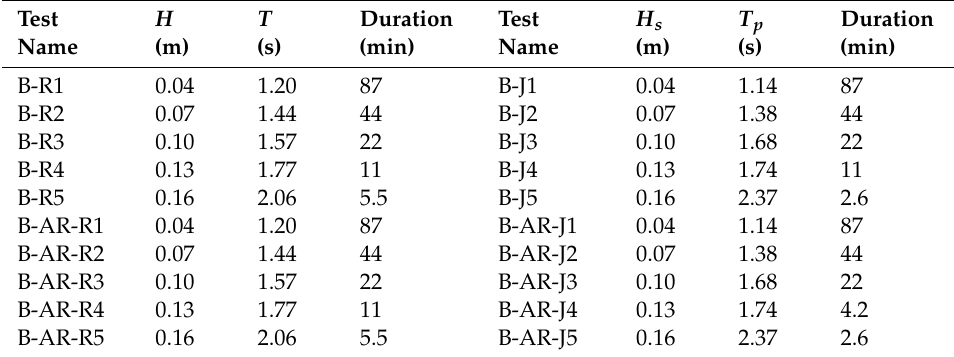
Table 1. Experimental conditions (R means regular wave, and J means irregular waves following JONSWAP spectra with γ = 3.3 and β = 0.065; Test Name consists of profile type and wave case, where B-AR and B indicates the beach with and without AR